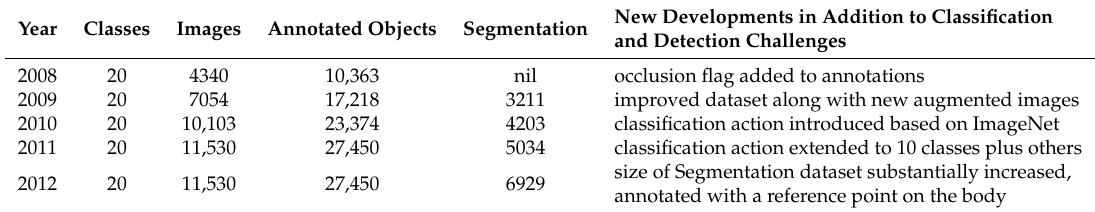
Table 5. Description of VOC dataset